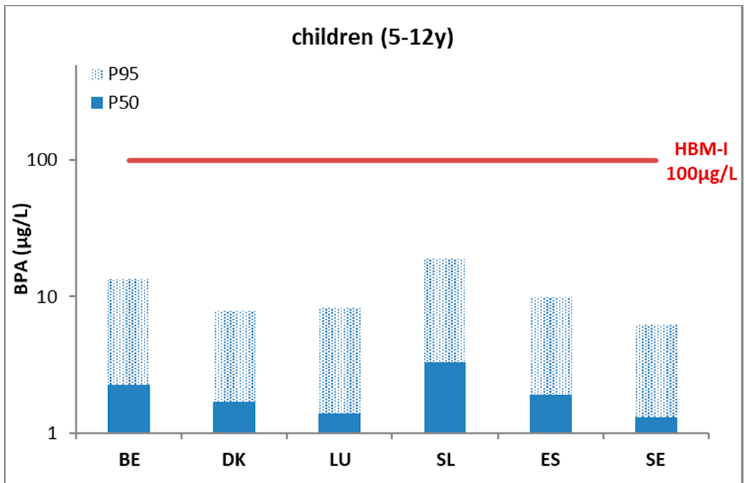
Figure 2 . Urinary levels (µg/L) of BPA-equivalents in children (50th and 95th percentile) in six EU countries (DEMOCOPHES) benchmarked against the German HBM-I guidance value below which no adverse health effects are expected according to current knowledge.